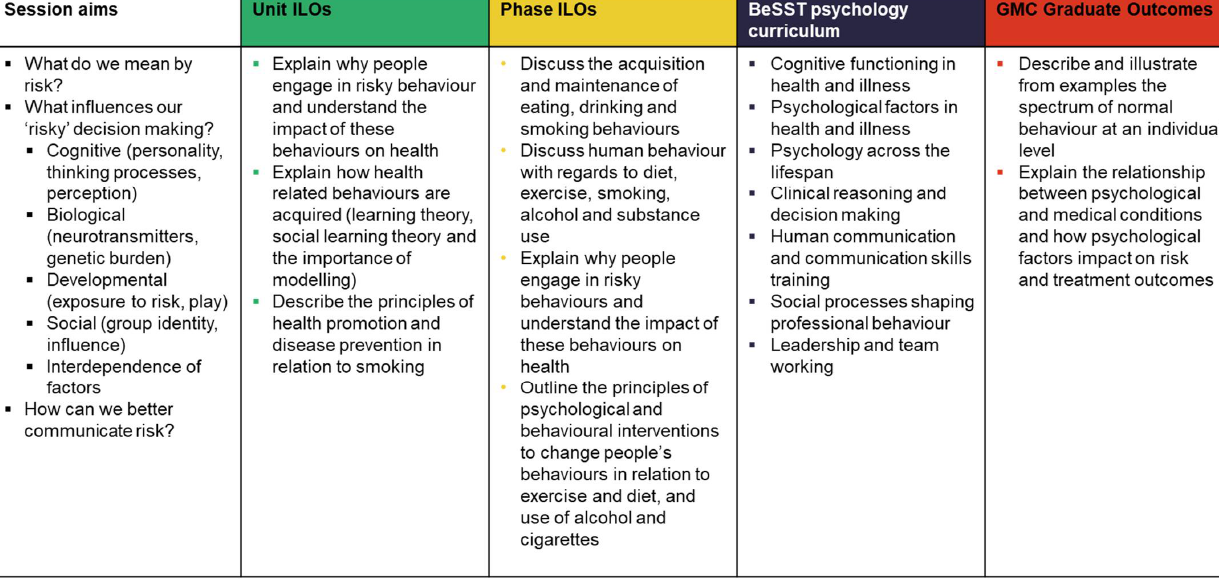
Figure 5. An example of how specific BSS learning content concerning ‘risk’ is mapped across different levels of intended learning outcomes (ILOs).